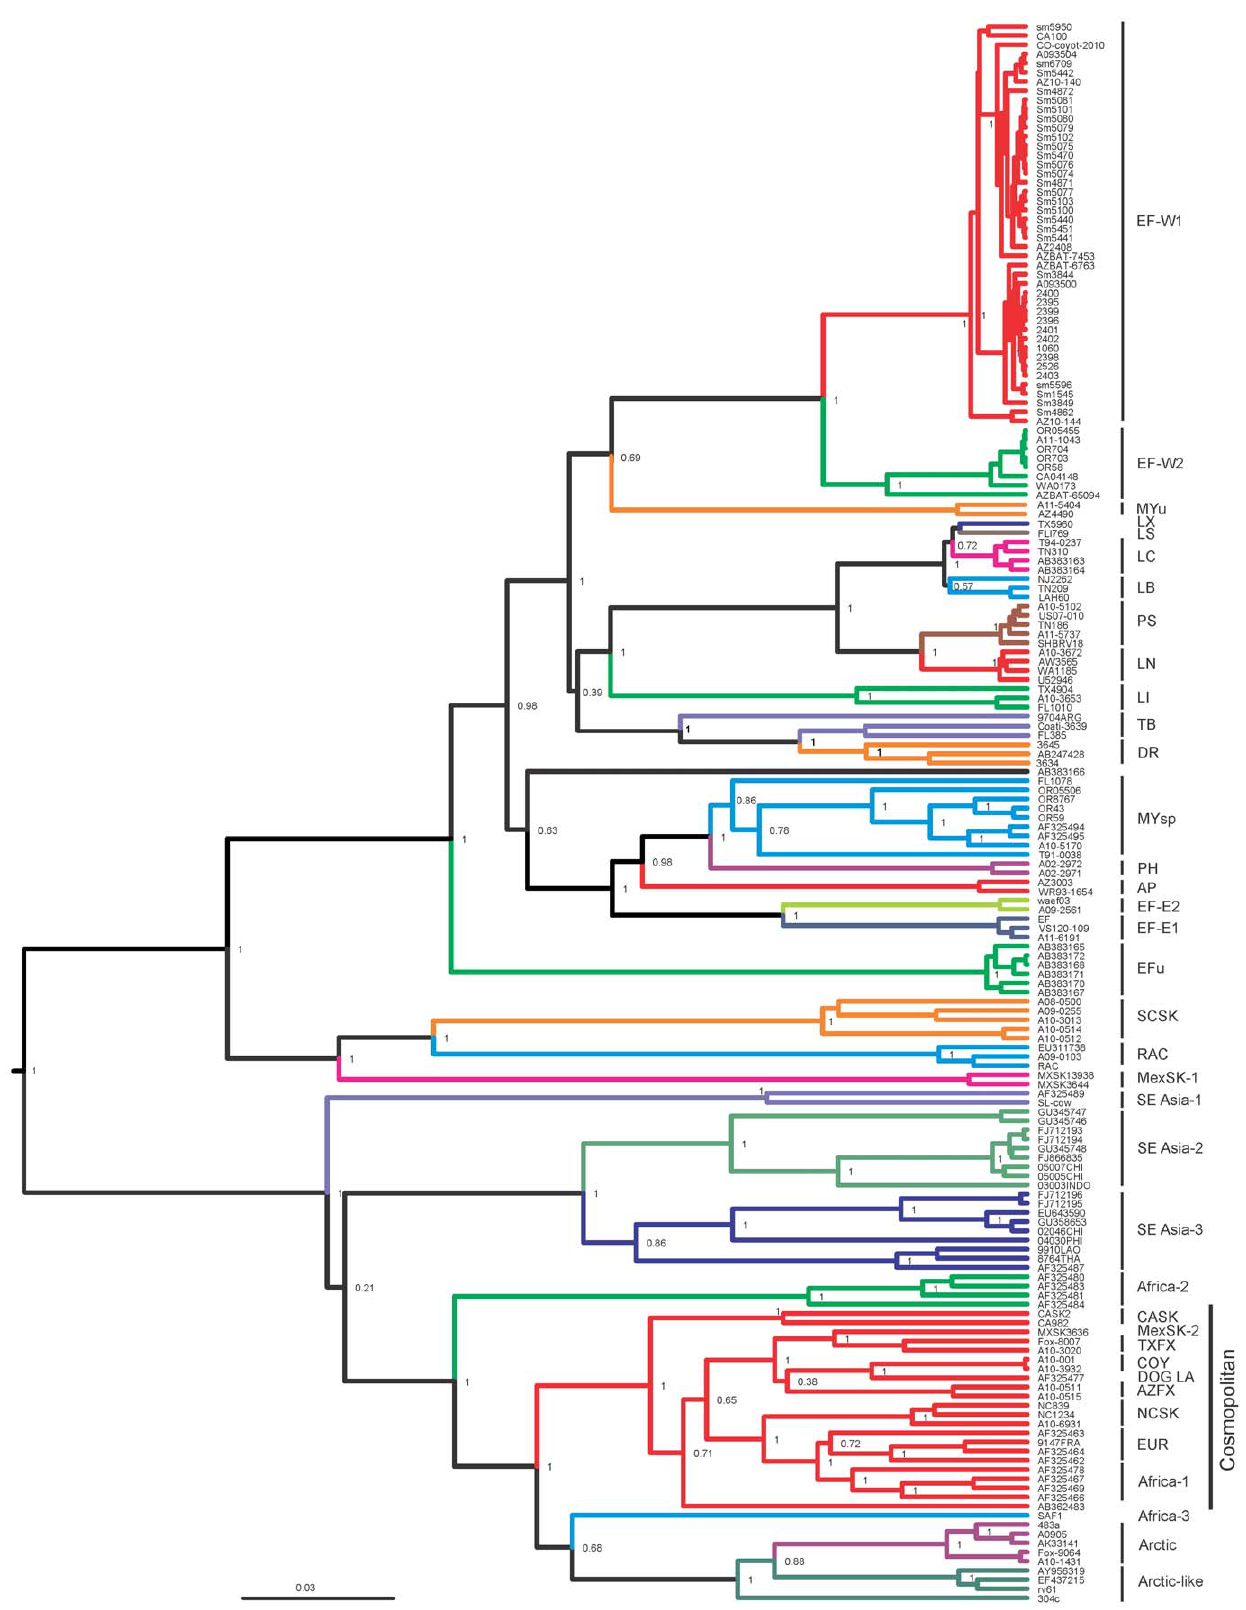
Figure 1. Bayesian tree of viruses, included in the study, based on the entire coding region of the G gene (1572 nuc). Lineage abbreviations: EF-W1 and EF-W2 – Eptesicus fuscus , with predominantly western distribution; MYu – Myotis yumanensis ; LX – Lasiurus xanthinus ; LS –